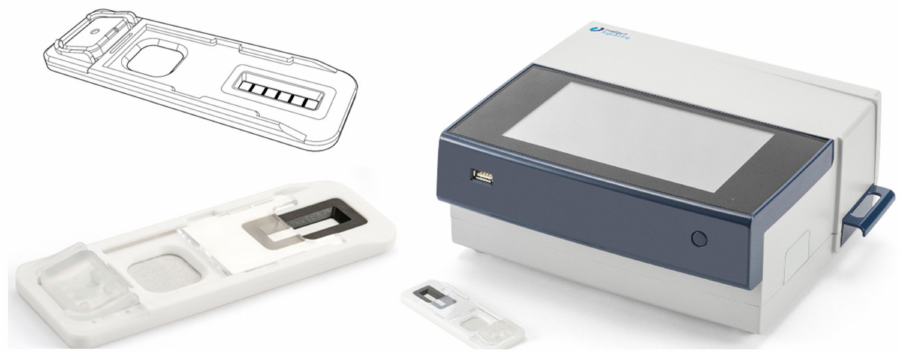
Figure 17. The Intelligent Fingerprint Drug Testing device (reproduced with permission from Oxford University Press